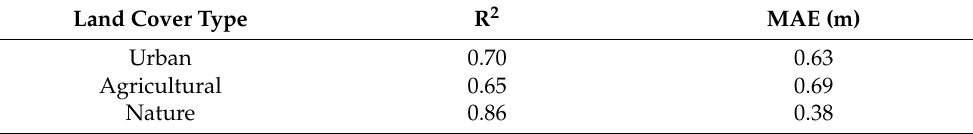
Table 3. Scores for the RF models trained with data from different locations based on land